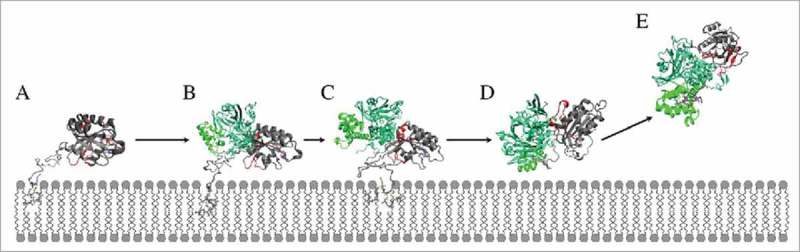
Mechanism of GG-Rab5 extraction from the endosome membrane into the cytoplasm. A sequential recognition and stabilization proceeds from (A) membrane-bound un-complexed Rab5(GDP) tilted towards the membrane surface with only partially accessible switch regions. (B) GDI recognizes Rab5 via its RBP and forms initial contacts with the switch regions. (C) The orientation of GDI slightly changes in order to allow interactions of the GDI CCR and the Rab5 HVR while the GG-binding pocket opens. (D) When the GG chains are accommodated within the GG-binding pocket, the Rab5(GDP):GDI complex detaches from the membrane. (E) The soluble complex is characterized by 1) manifold interactions between the GDI RBP and Rab5 switch regions, 2) Rab-specific recognition of Rab5 HVR by the GDI CCR, and 3) an opening of the GG-binding pocket with Rab5 GG-chains inserted.